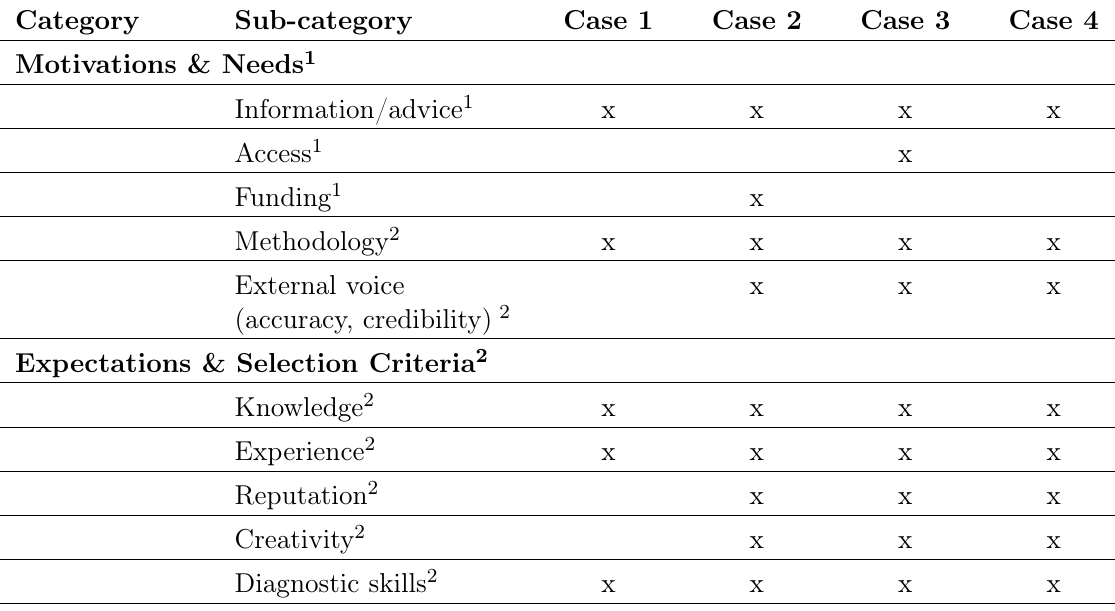
Table 4. Categories and